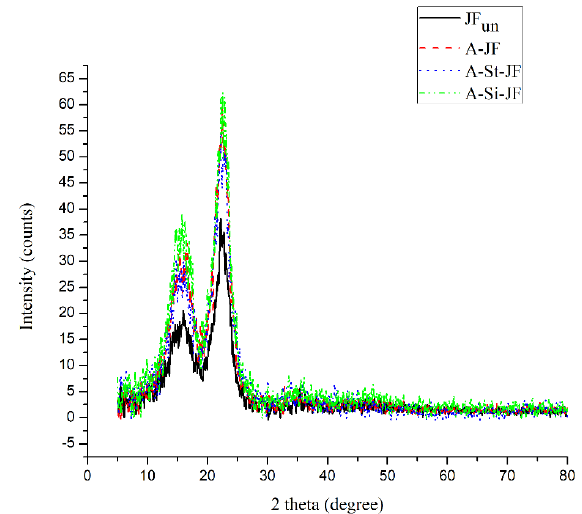
Figure 2. XRD pattern of unmodified and surface modified JFs.